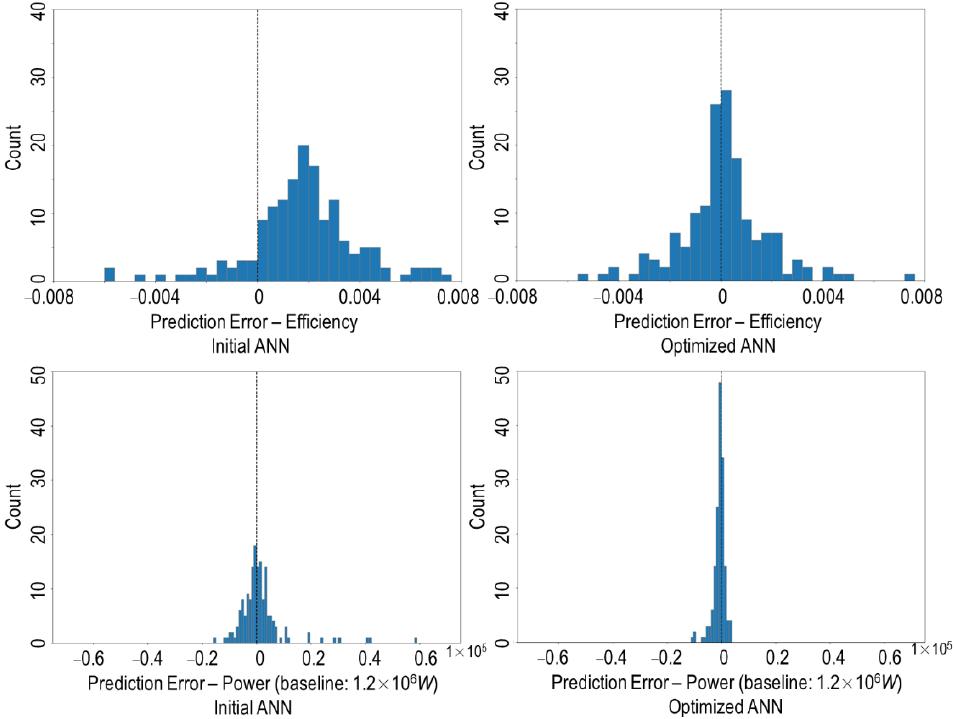
Figure 4. Histogram plots of the prediction errors of the initial and optimized ANN models.